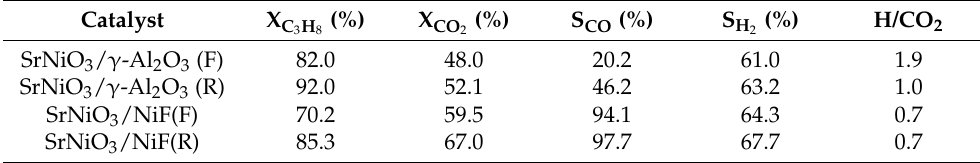
Table 2. C 3 H 8 and CO conversion, CO, H 2 selectivity, and H 2 /CO ratio.